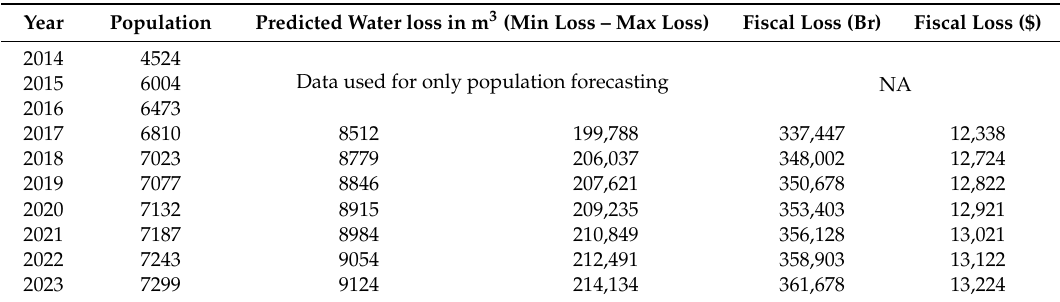
Table 5. Population forecasted using geometrical increase rate of growth, fiscal loss forecasting,